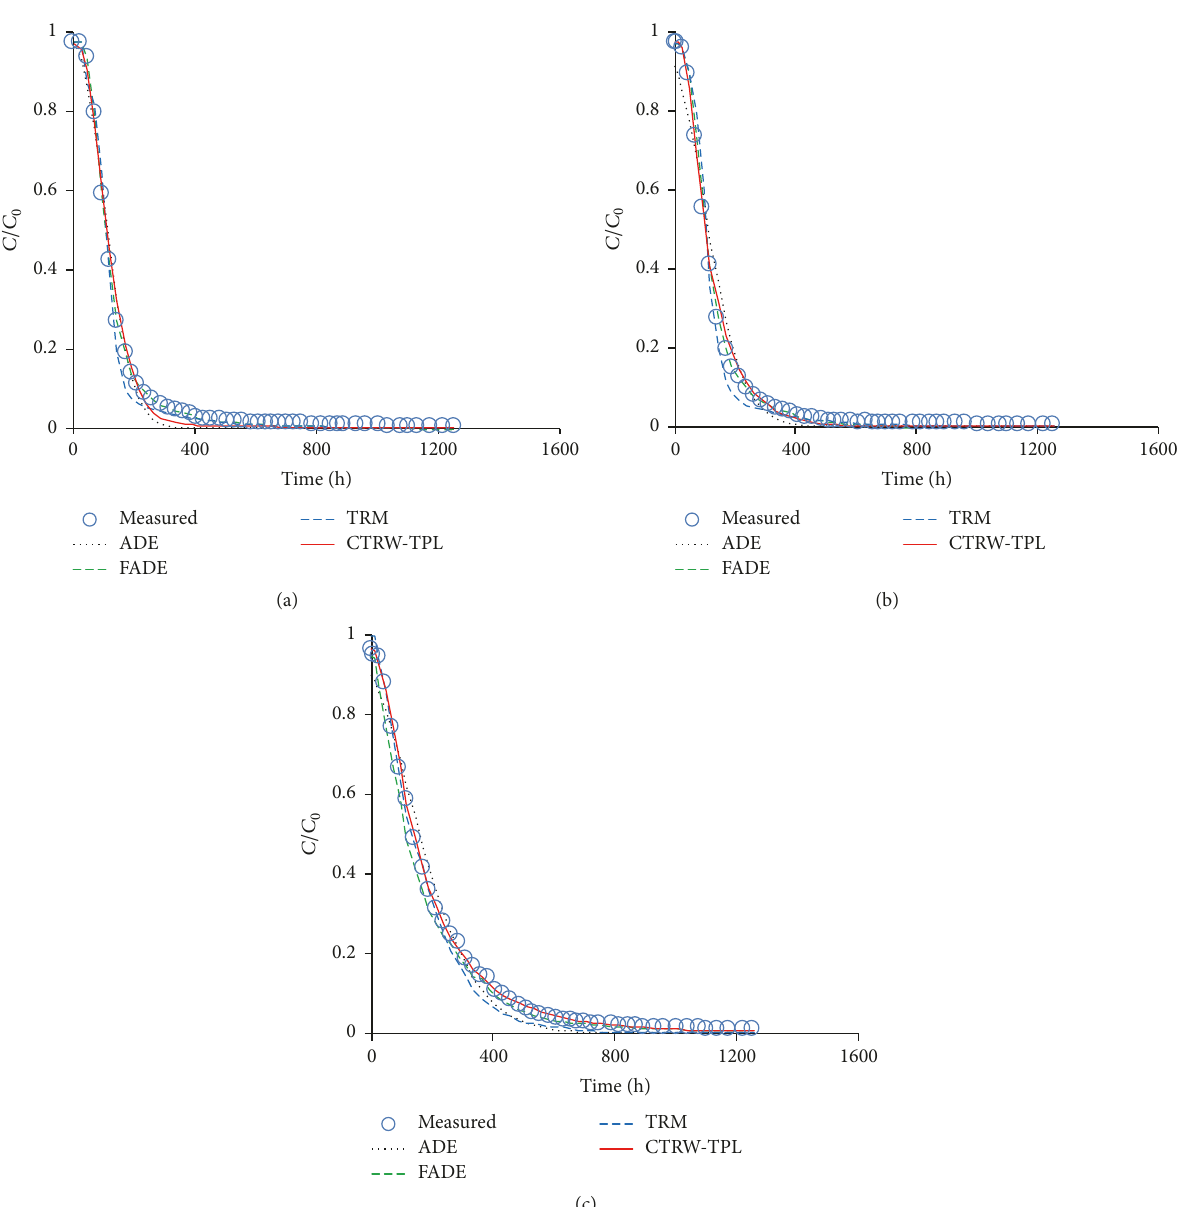
Figure 7: Three sets of measured leaching curves fitted with ADE, FADE, TRM, and CTRW (based on TPL), for the homogeneous, saturated, and smooth wall soil columns with the same column length (5 cm) but different column inner diameters: (a) 7 cm; (b) 9 cm; (c) 10 cm. discrepancy to the specific makeup of heterogeneities in the columns. The estimated 𝜆 values for FADE were in the range of 1.7, which was considerably smaller than 2.00 (Table